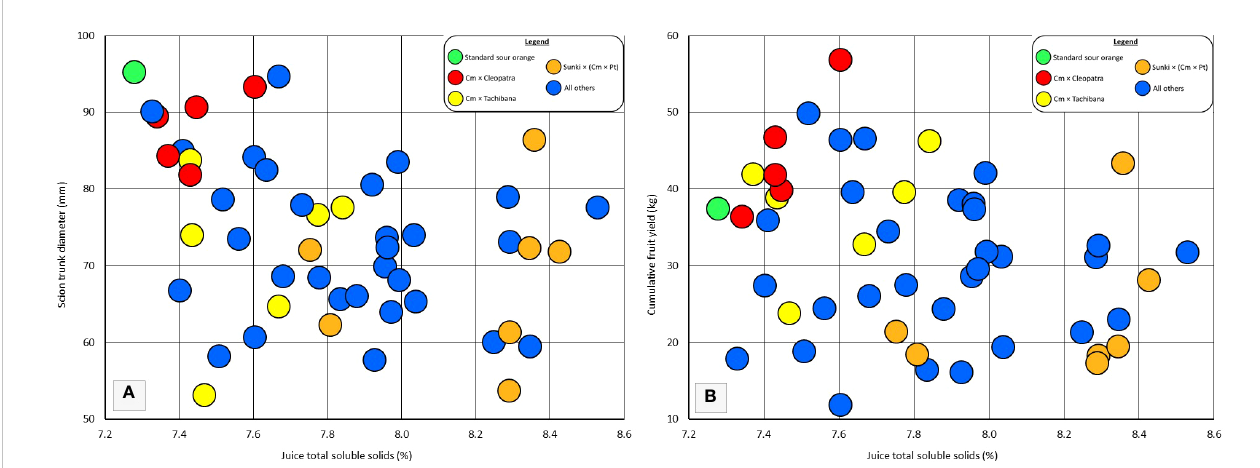
FIGURE 4 Individual and progeny rootstock effects for juice total soluble solids in comparison with (A) scion trunk diameter, and (B) cumulative fruit yield. All Other = rootstocks that are not standard sour orange or the three hybrid progeny groups speci fi cally identi fi